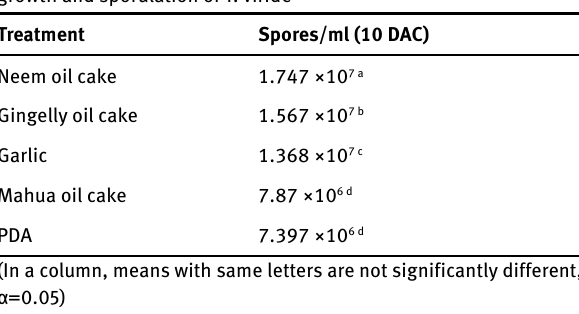
Yellowing Yellowing